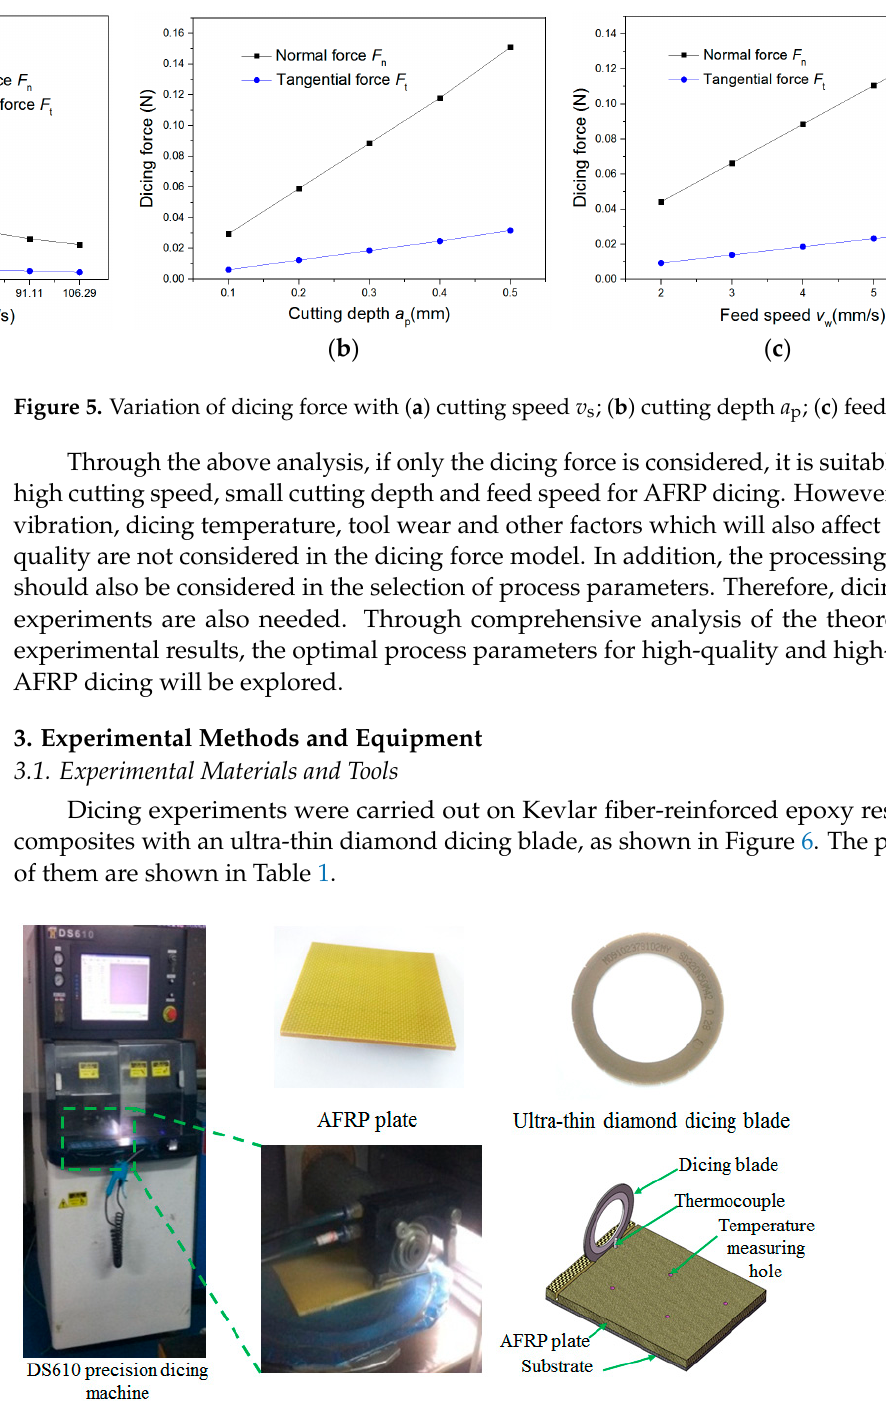
Figure 6. Workpiece materials, tools and dicing machine.